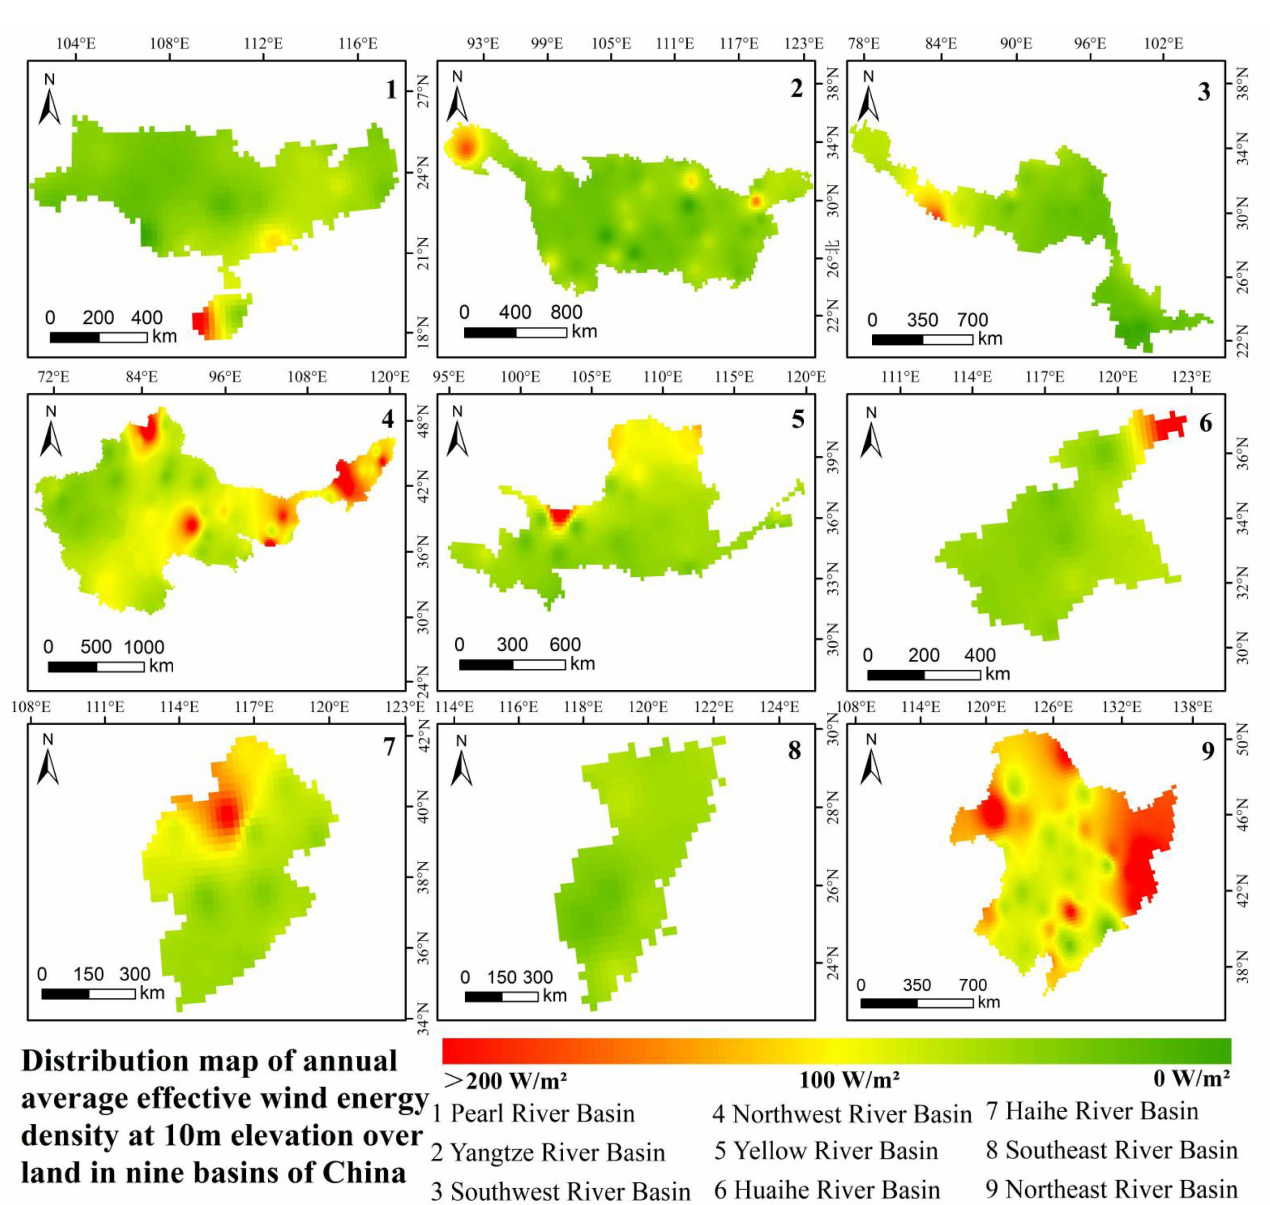
Figure 5. Spatial distribution of annual average effective wind energy density in Chinese river